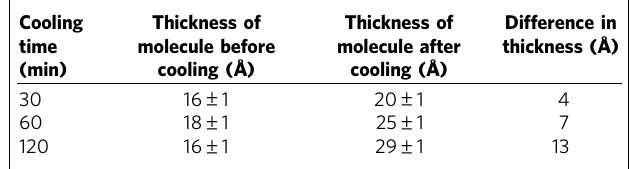
Table 1 | Monolayer thickness as a function of cooling time at 70K extracted from ellipsometry for a monolayer made from NH 2 -{Ala-Aib} 8 -COCHNH 2 CH 2 PO 4 H 2 and adsorbed on Si/SiOx.